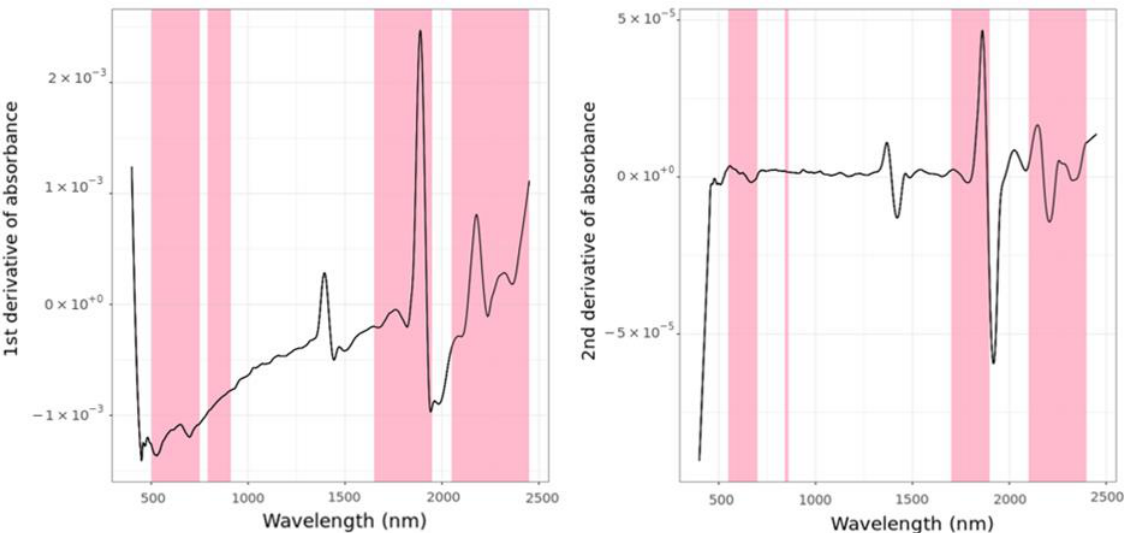
Figure 6. 1st and 2nd derivatives of the laboratory (PSR+ 3500) spectral signature with a high OM content. The important spectral regions are highlighted in pink. The interval size varies according to the preprocessing method applied.